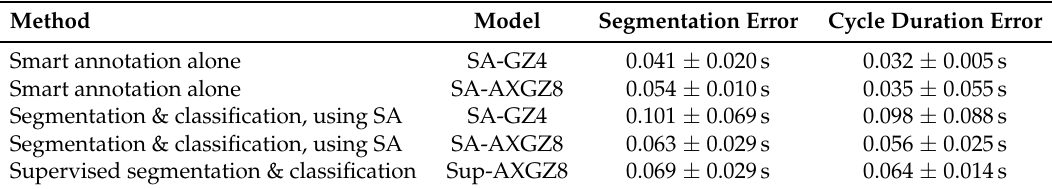
Table 2. Mean absolute error in segmentation of stride borders (SB) relative to manual segmentation and mean absolute error in cycle duration (stride time).